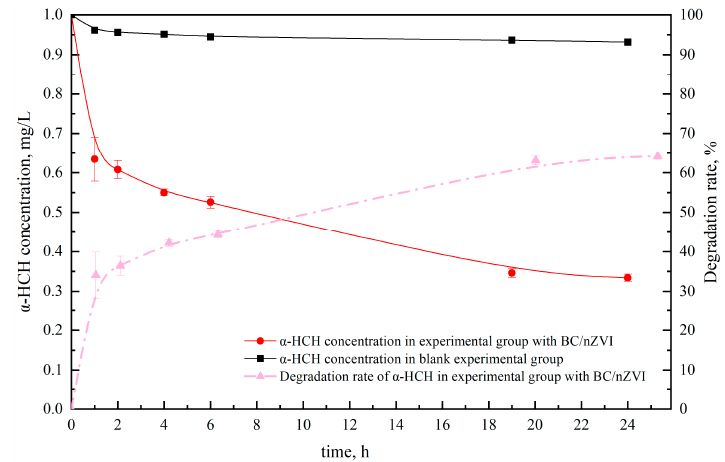
Figure 2. Effects of BC/nZVI material on the degradation of α -HCH in water.